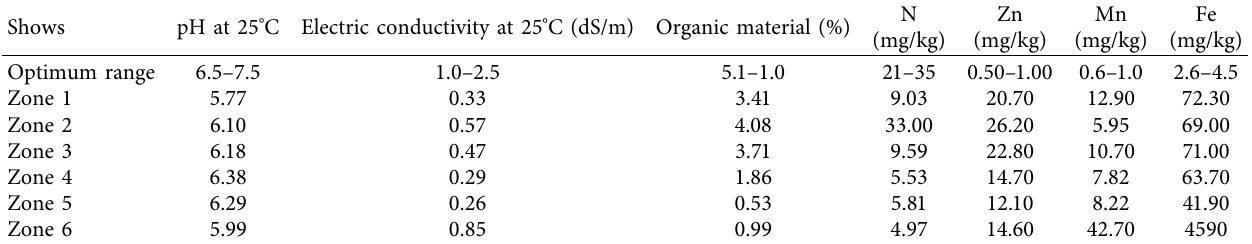
Table 2: Values of fertility analysis in samples from soil collected from Los Maitenes wetland. Shows Optimum range